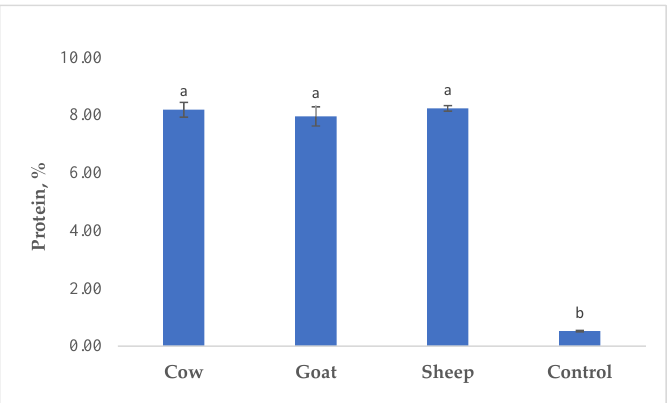
Figure 1. Protein content (%) in probiotic fermented whey beverages enriched with kiwi powder. a,b Means ± standard deviations with different superscript uppercase letters are significantly different ( p < 0.05). Table 1. Lactic acid (%) and viable bacteria count (log CFU/mL) changes in probiotic fermented whey beverages enriched with kiwi powder during storage.